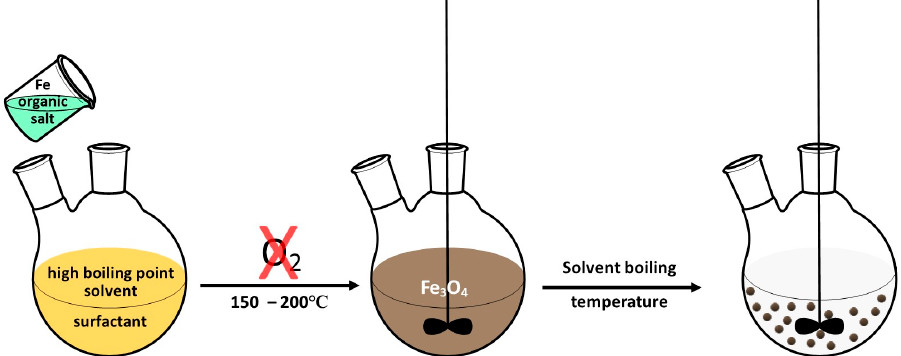
Figure 3. Synthesis of magnetite nanoparticles by thermal decomposition.